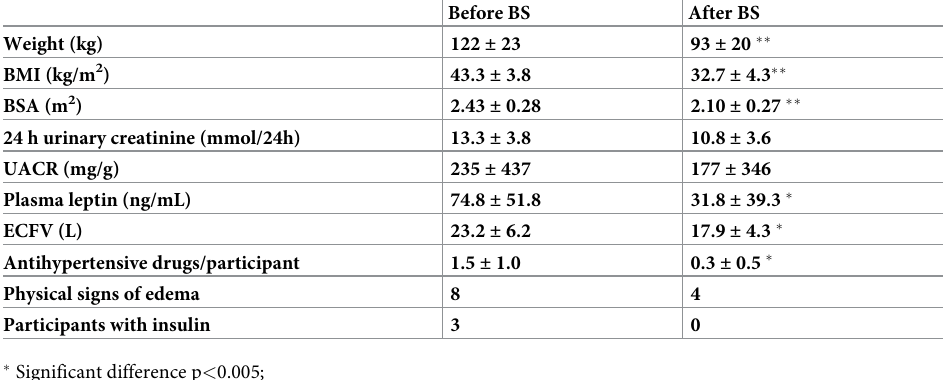
eGFR = estimated glomerular filtration rate; BMI = body mass